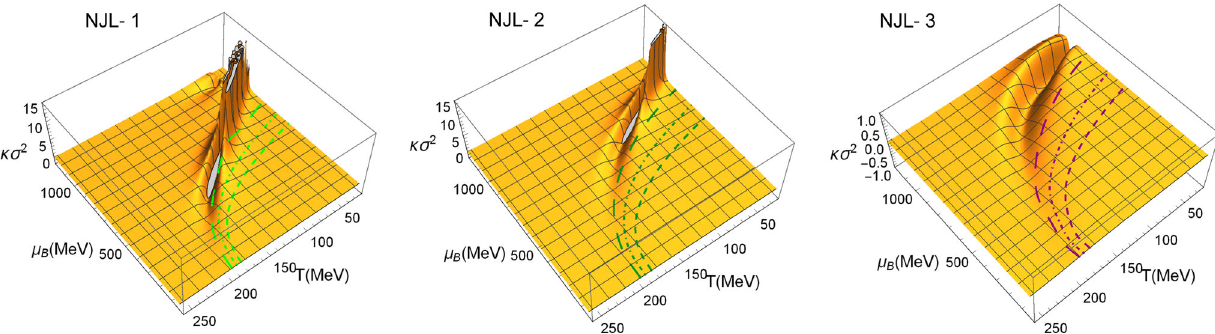
Fig. 2 The 3D plot for the kurtosis of the baryon number fluctuation κσ 2 as a function of the temperature and baryon chemical potential in the NJL model. The long dashed, dashed-dotted and dashed lines in